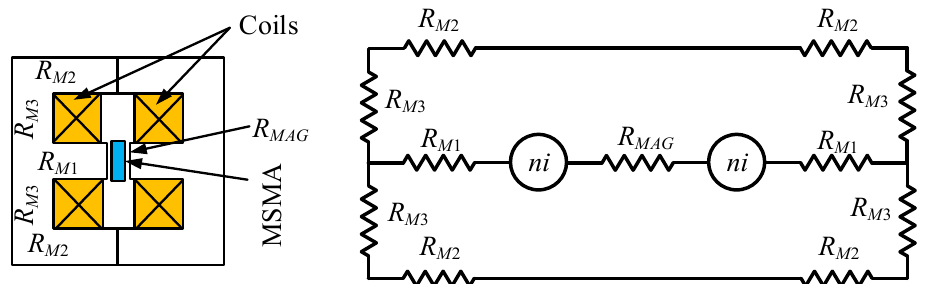
Figure 5. Equivalent magnetic circuit.